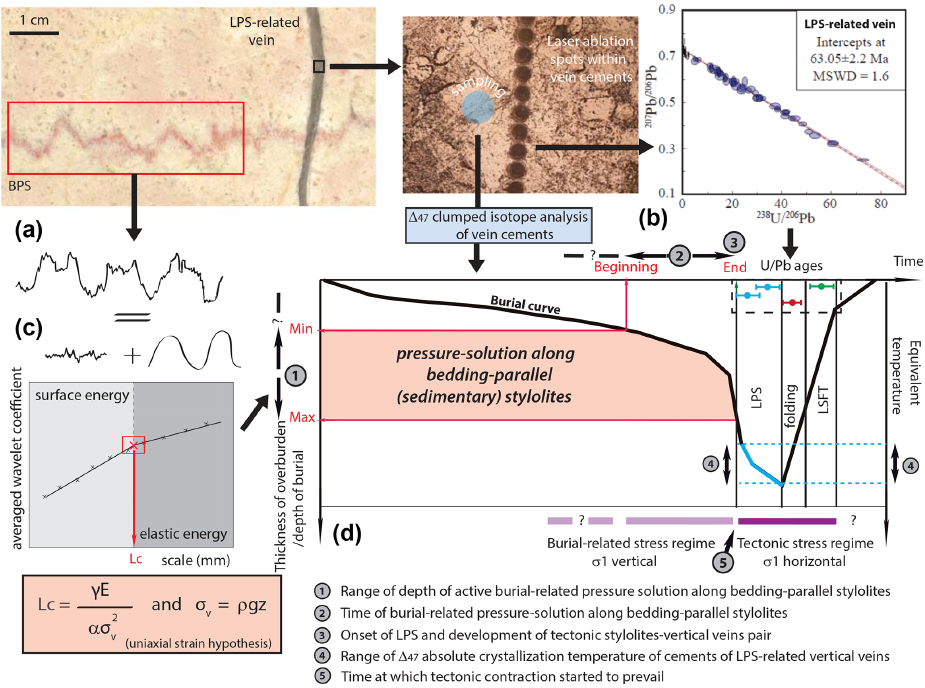
Figure 2. Principle of the dating of mesostructures related to the folding event. (a) Photograph of a bedding-parallel sedimentary stylolite cut by a vertical vein related to layer-parallel shortening (LPS). (b) Principle of dating calcite veins using LA-ICP-MS, with laser ablation spots and final Tera–Wasserburg diagram. (c) Principle of inversion of the roughness of sedimentary stylolites for stress. σ v is the vertical stress, α = (( 1 − 2 ν) · ( 1 + ν) 2 )/( 30 π( 1 − ν) 2 ) , γ is the solid–fluid interfacial energy, ν is the Poisson ratio, E is the Young modulus, ρ is the dry density, g is the gravitational field acceleration, and z is the depth. (d) Principle of the combination of U–Pb dating and absolute (cid:49) 47 thermometry of calcite cements (here for LPS-related veins) with maximum depth of burial-related dissolution inferred from roughness inversion of sedimentary stylolites and burial-time evolution of strata to derive the timing of deformation stages during the folding